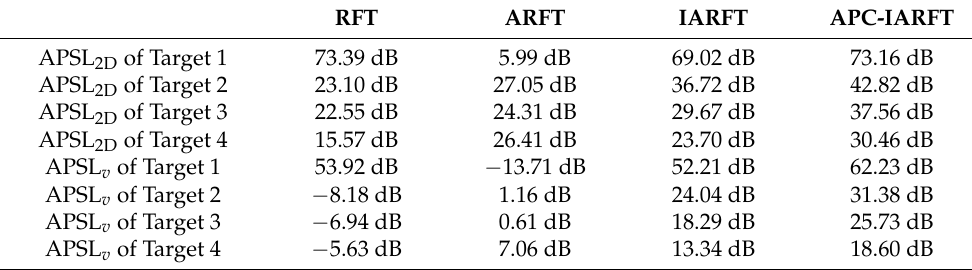
Table 4. APSL 2D and APSL v of the targets set in Scenario 2.